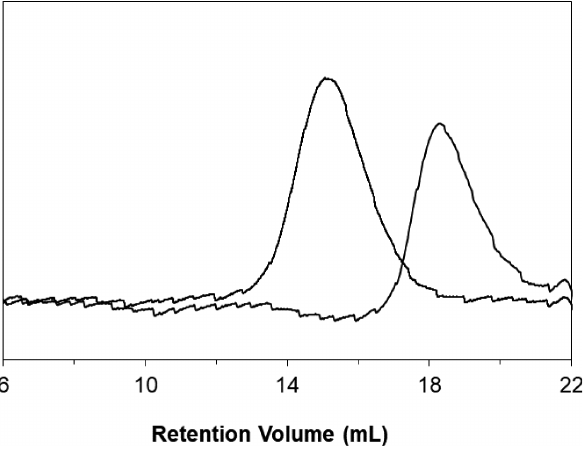
Figure 2: SEC curves for ATRP macroinitiator PEG-TTE-Br (right curve) and diblock copolymer Polymer 2 (left curve).